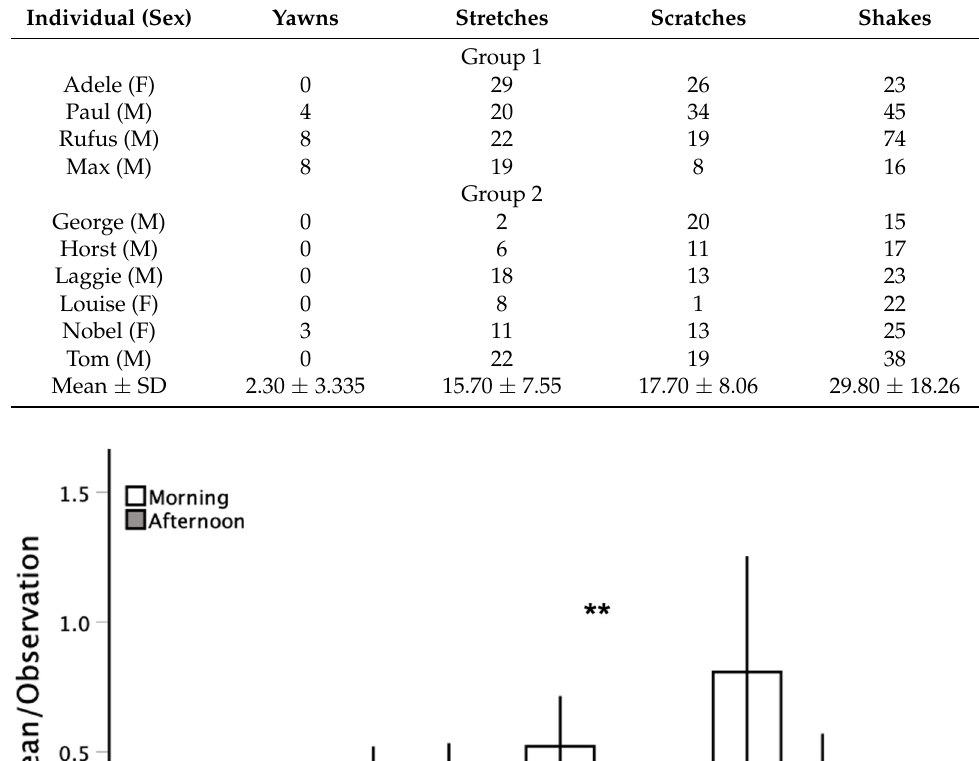
Table 2. Total behavioral frequencies across the individual birds (M = male; F = female).